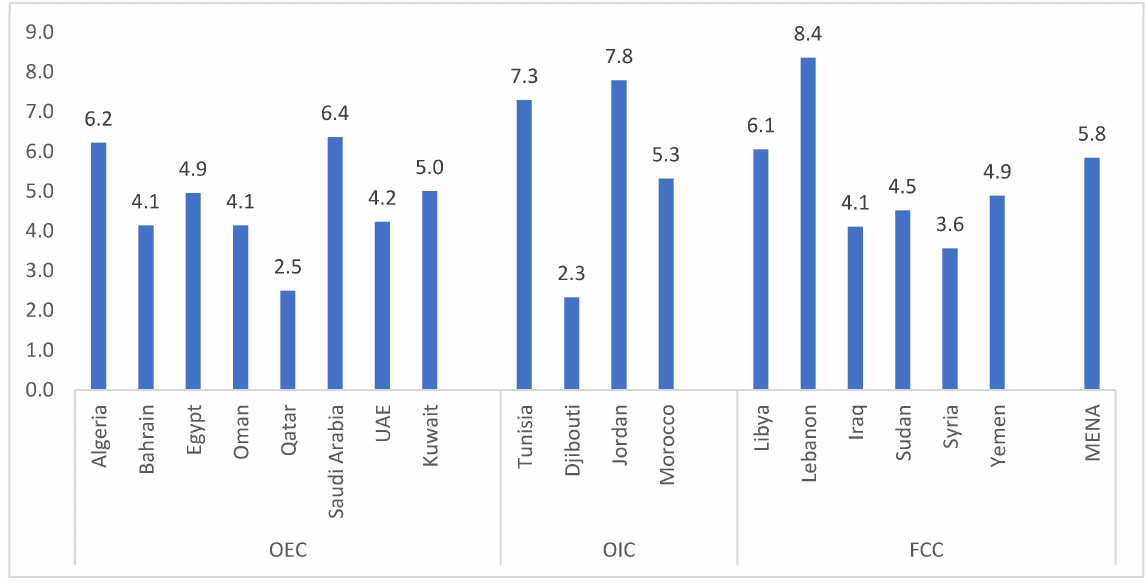
Figure 2. Current health expenditure in 2018 (% of GDP). Source: World Development Indicators. Available online: https://datacatalog.worldbank.org/ (accessed on 15 July 2021). Note: FCC: Fragile Crisis affected Countries, OEC: Oil Exporting Countries, and OIC: Oil Importing Countries.